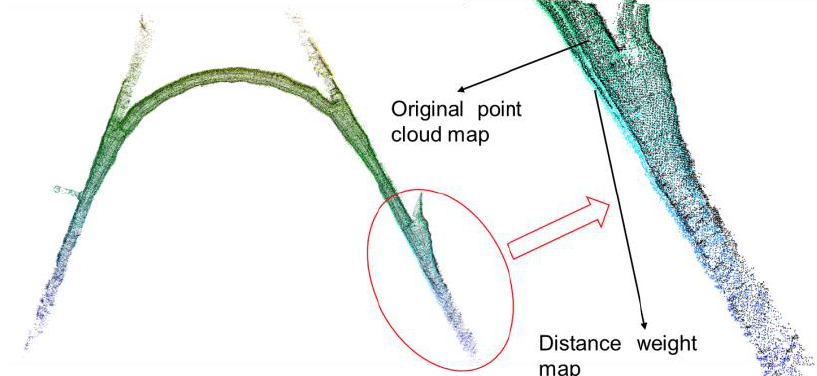
Figure 6. Distance weight map and non-distance weight map comparison.